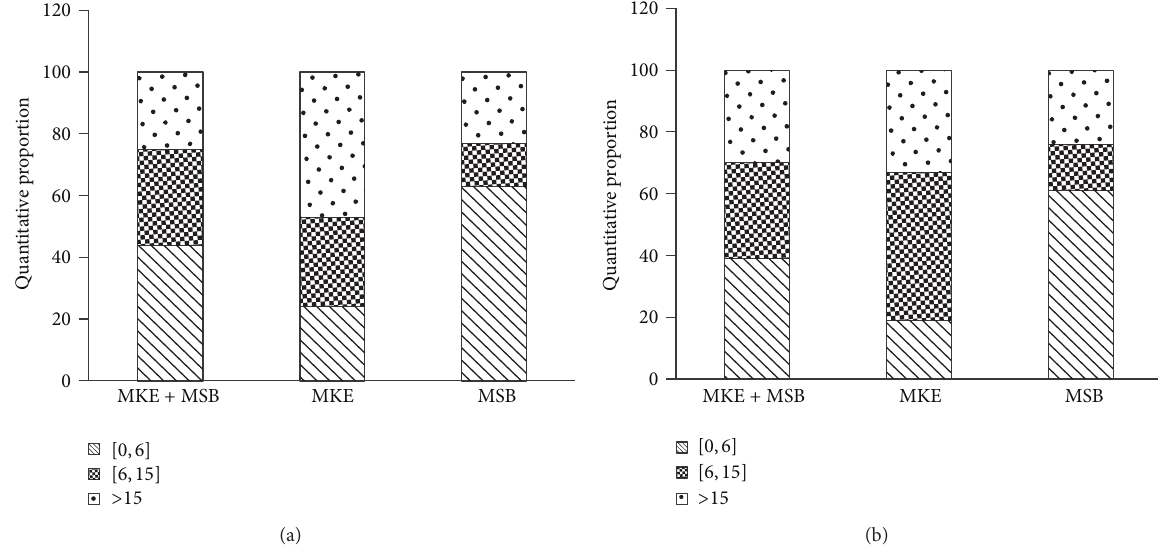
Figure 6: Comparisons of quantitative proportion of the monitoring sites in different slope areas for SOM (a) and SWC (b) corresponding to the three